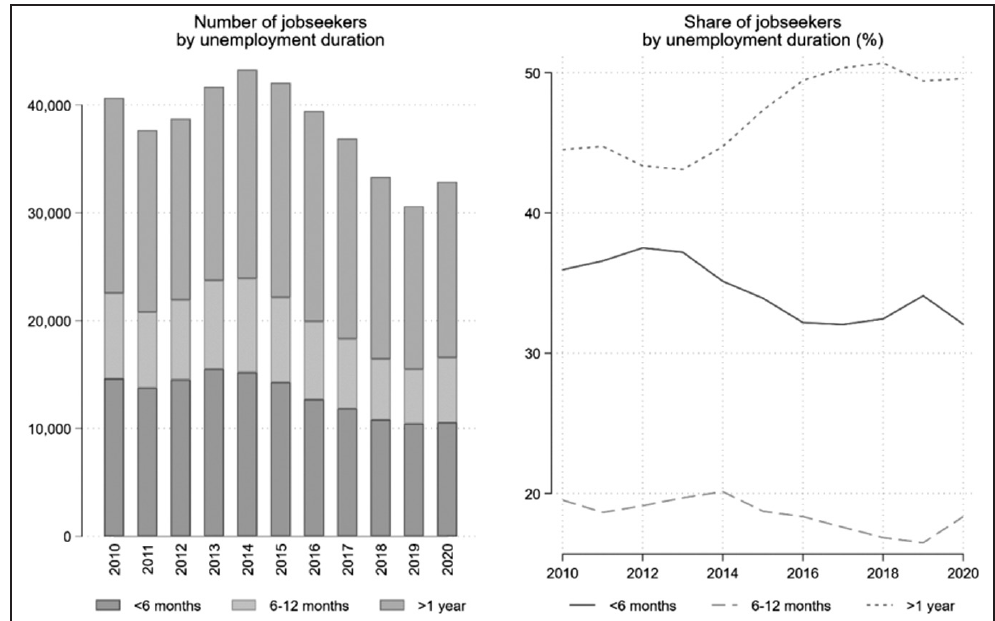
The evolution of long-term unemployment in Flanders among jobseekers aged 40–48